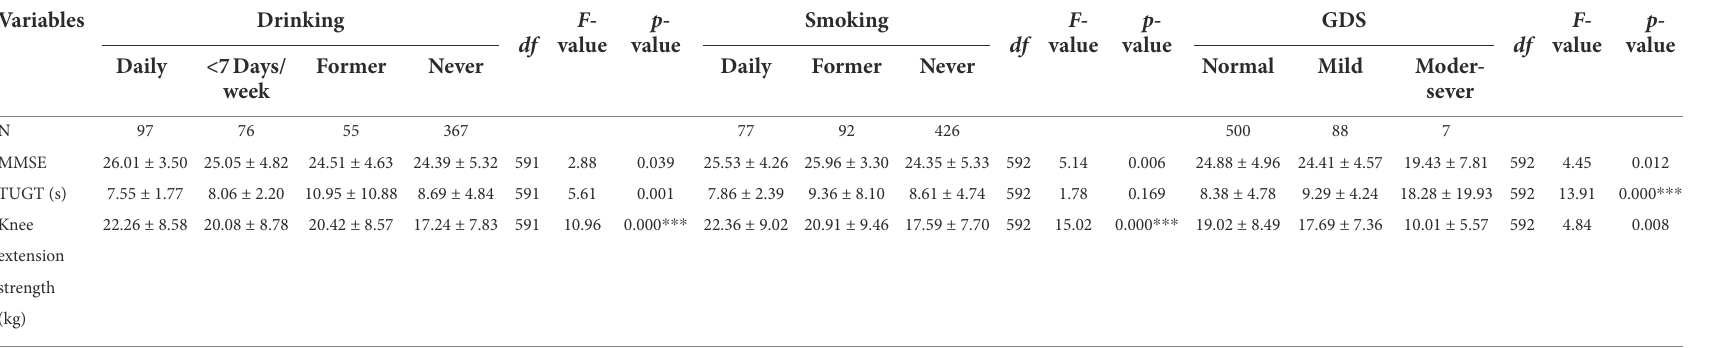
TABLE 2 Differences of MMSE, TUGT and knee extension strength in demographic variables ( N = 595). Variables